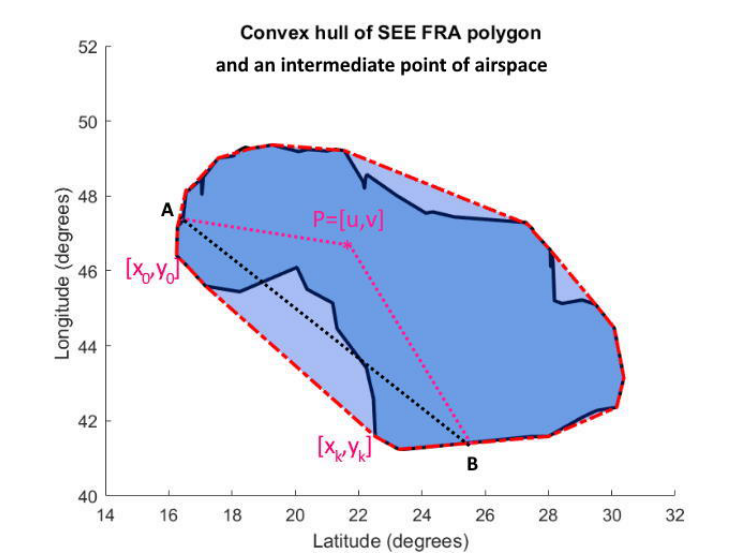
Figure 5. SEE FRA airspace polygon and its convex